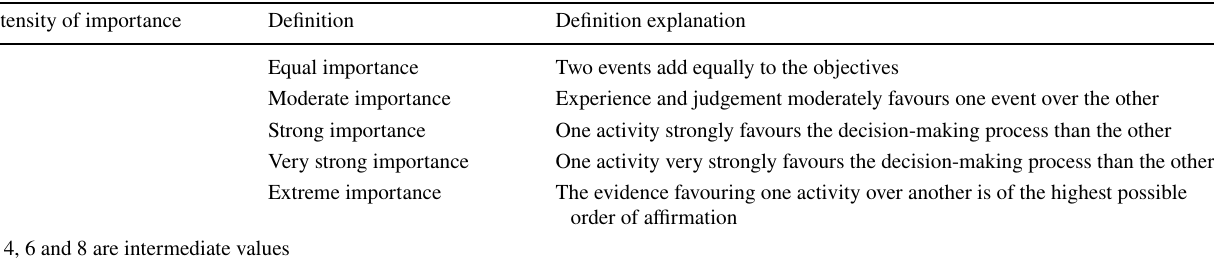
Table 3 Saaty’s pairwise comparison scale Intensity of importance